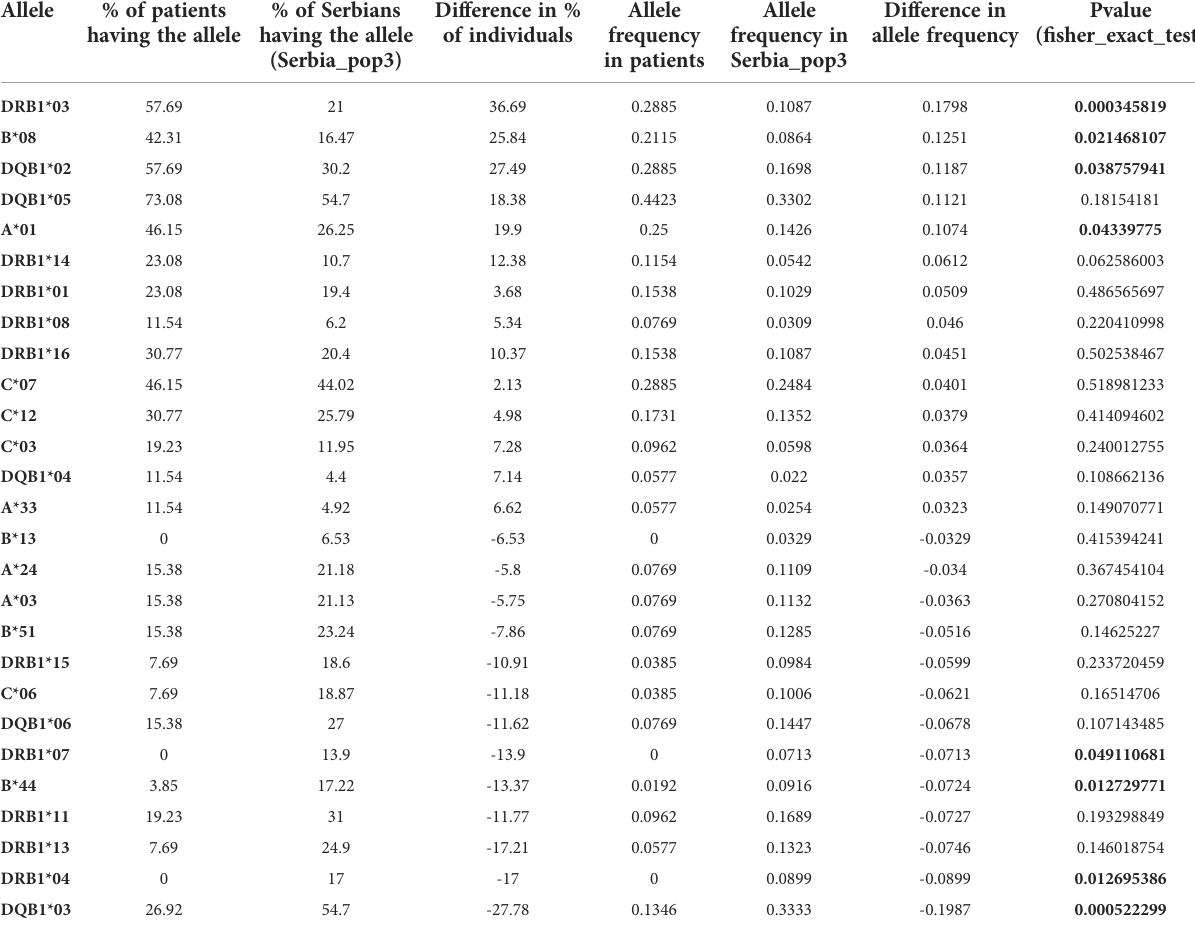
The table is sorted by the difference in allele frequency (last column). The full list is in the supplementary fi le 1 data sheet “ Belgrade_HLA. ” Bold values indicate signi fi cant alleles. “ * ” means by DNA sequencing.